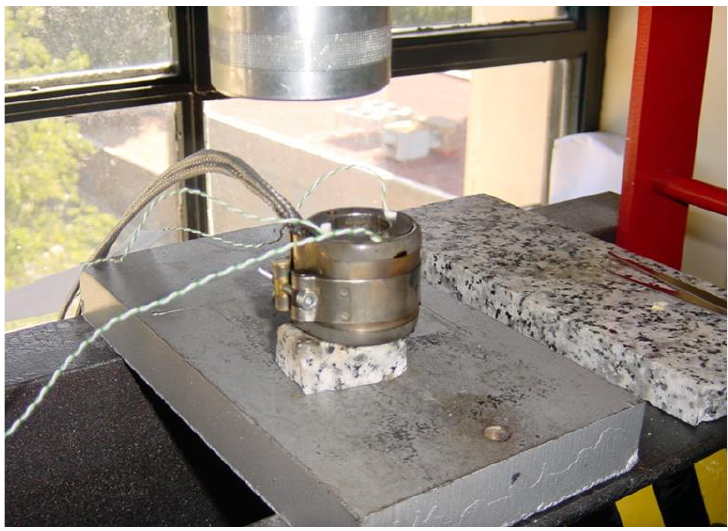
Figure 3. Experimental setup of mold with all the thermocouples in the mold to control the temper- ature.